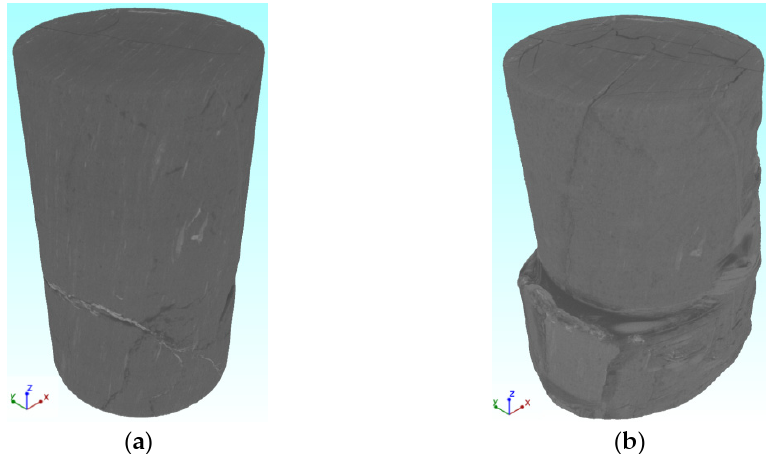
Figure 3. 3D reconstruction model at the initial ( a ) and post-peak stages ( b ).